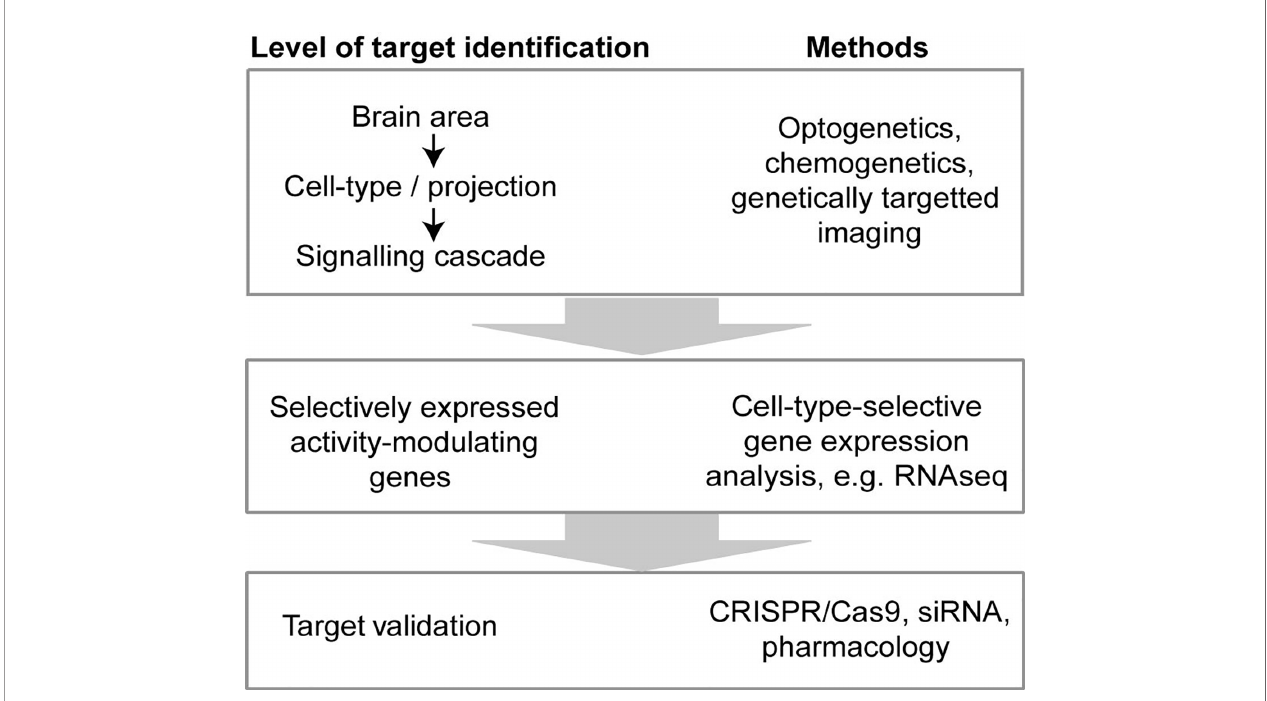
FIGURE 1 | A circuit-neuroscience approach to drug discovery. Combining the optogenetic or chemogenetic modulation (Tye and Deisseroth, 2012; Deisseroth, 2014; Sternson and Roth, 2014) and imaging (Grewe et al., 2017; Ghosh et al., 2011) of genetically speci fi ed cell-types with behavioral testing in rodents, the brain areas, cell-types, speci fi c projections, and potentially even signaling cascades that underlie certain cognitive functions can be identi fi ed (Kätzel and Kullmann, 2015). As a next step, genes selectively expressed in the identi fi ed cell-types can be revealed (Saunders et al., 2018; Tasic et al., 2018), which modulate neuronal activity. The proteins encoded by such genes can be ablated in these genetically speci fi ed cell-types using e.g. CRISPR/Cas9 (Swiech et al., 2015), or modulated systemically by pharmacology to validate their suitability as molecular treatment